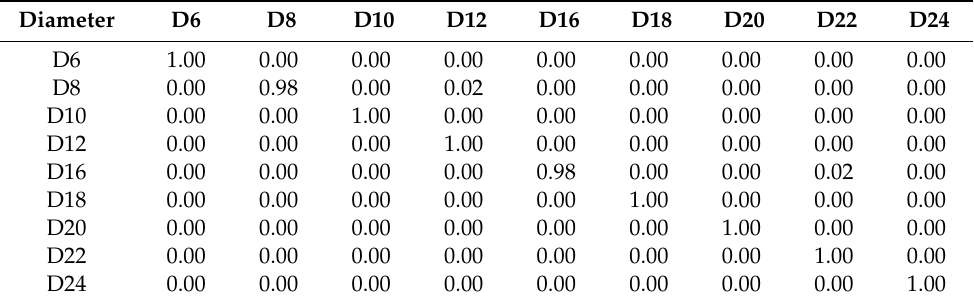
Table 2. Confusion matrix obtained by CNN-LSTM on simulated datasets. Diameter